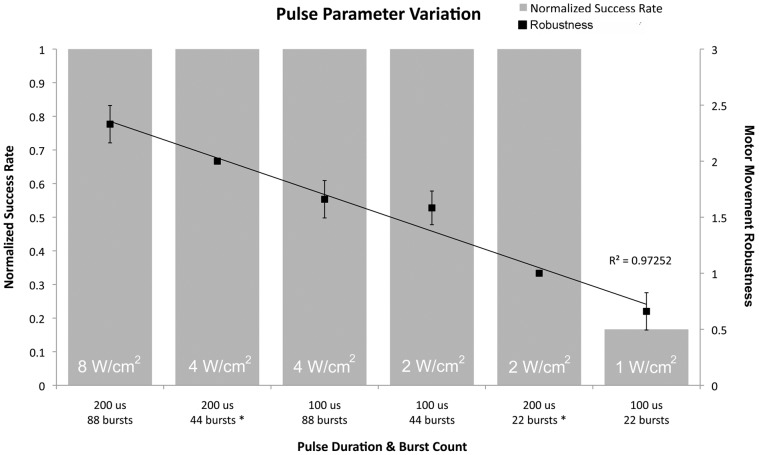
Intensity sweep of modulated focused ultrasound.Intensities shown are spatial peak temporal average values. Robustness data were linearly fit with R2 = 0.97252.